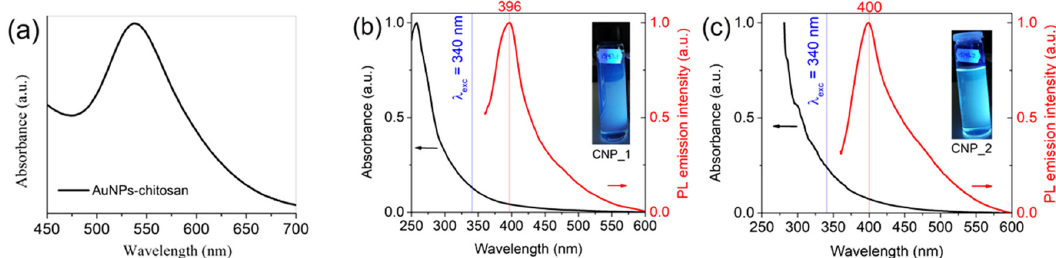
Figure 2. Optical properties of synthesized nanoparticles: ( a ) optical absorption spectrum of chitosan-stabilized gold nanoparticles (AuNPs–chitosan); ( b ) optical absorption and photoluminescence (PL) spectra of carbon nanoparticles (CNPs; excitation wavelength, λ exc = 340 nm) obtained for a laser fluence of 2 J/cm (CNP_1) and ( c ) for a laser fluence of 3 J/cm (CNP_2). The inset photos in Figure 2b,c show the fluorescence of CNP suspensions taken under 365 nm UV light.